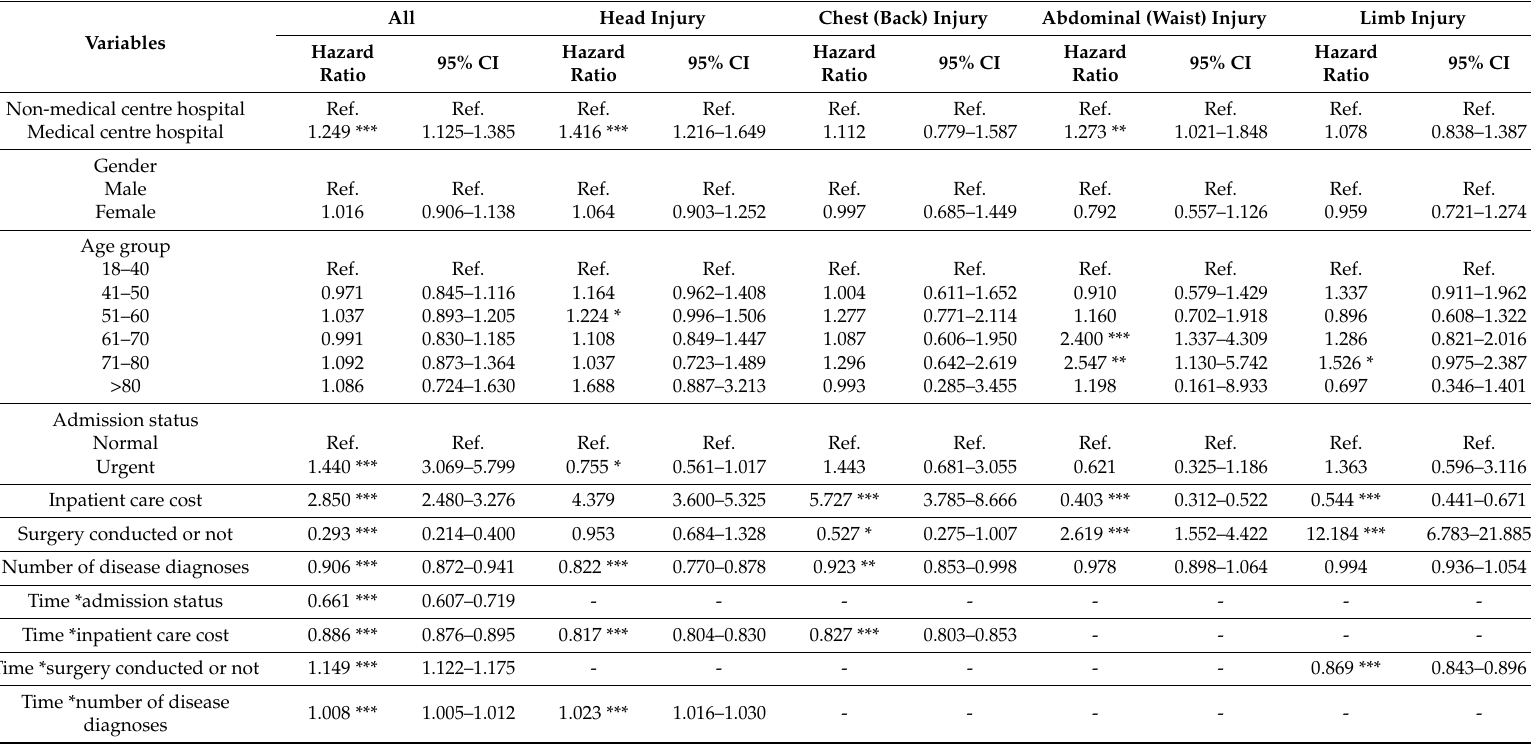
Table 3. Maximum likelihood estimates of multivariable Cox hazard